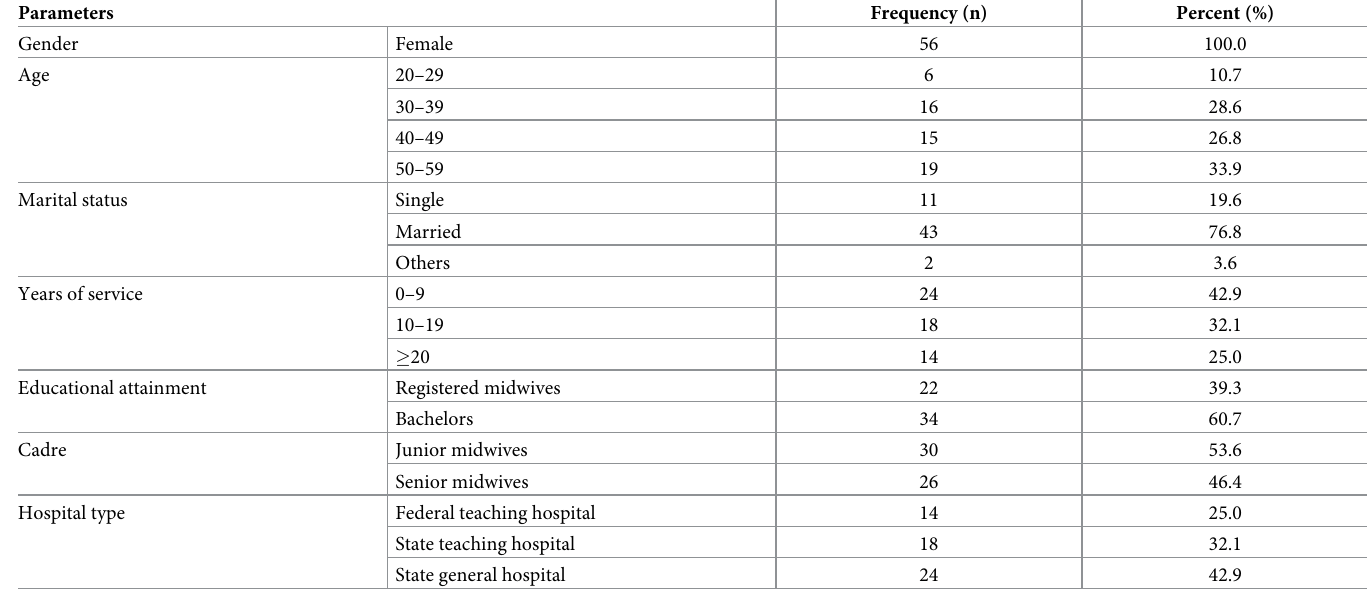
Table 8. Basic characteristics of focus group